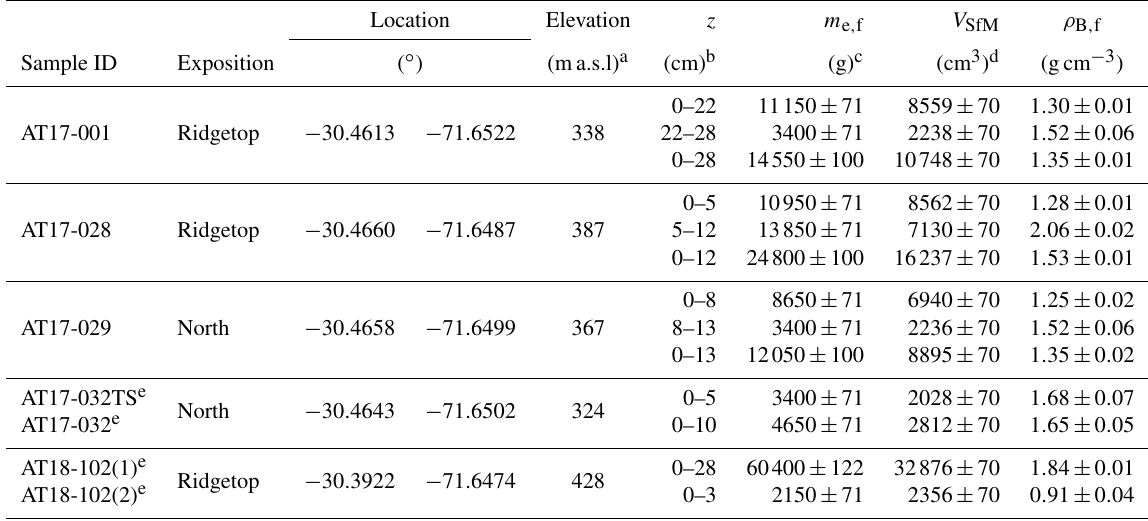
Table 6. Field-state bulk density ( ρ B , f ) consistency and precision control for AT17–18 samples.